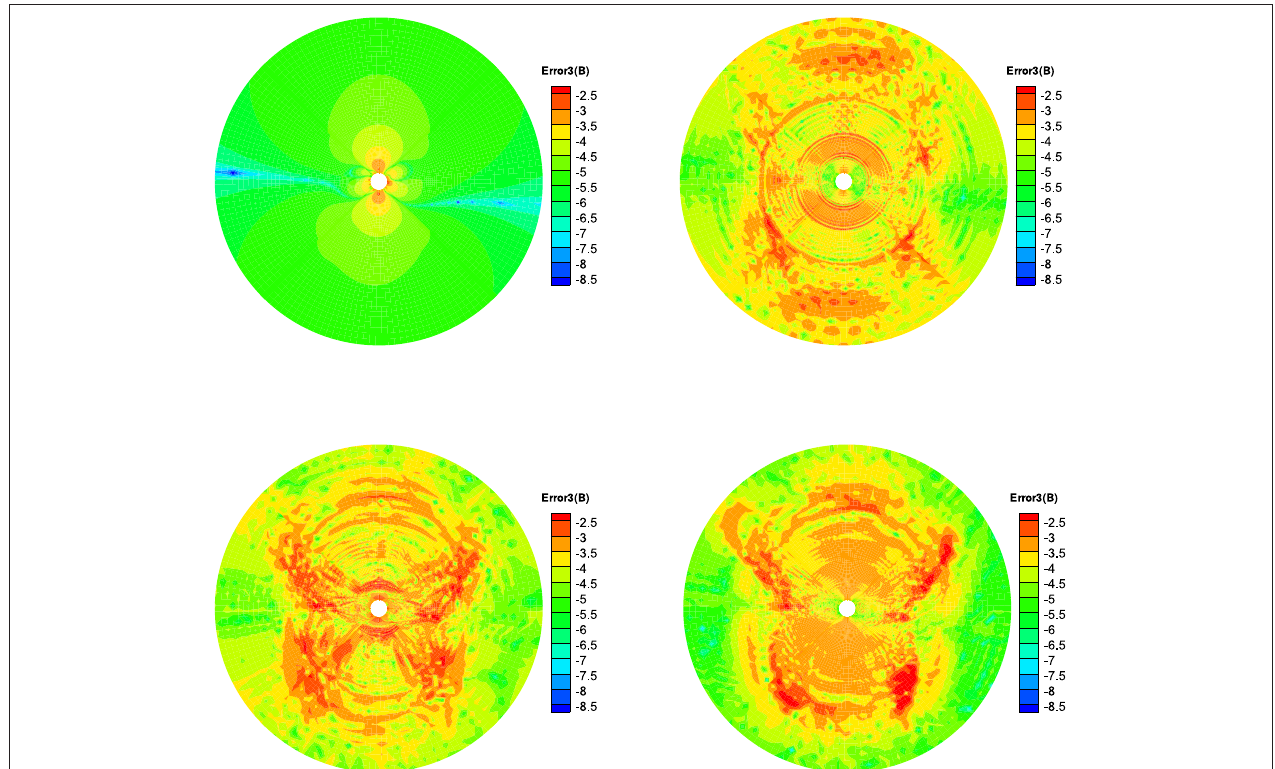
FIGURE 9 | The log 10 Error3 (B) in the calculation at t = 5h on the meridional plane of φ = 180 ◦ − 0 ◦ from 1 to 20 R s , the results from CT method (left) and diffusive method (right) are displayed in the top row, the bottom row follows from the projection method (left) and GLM method